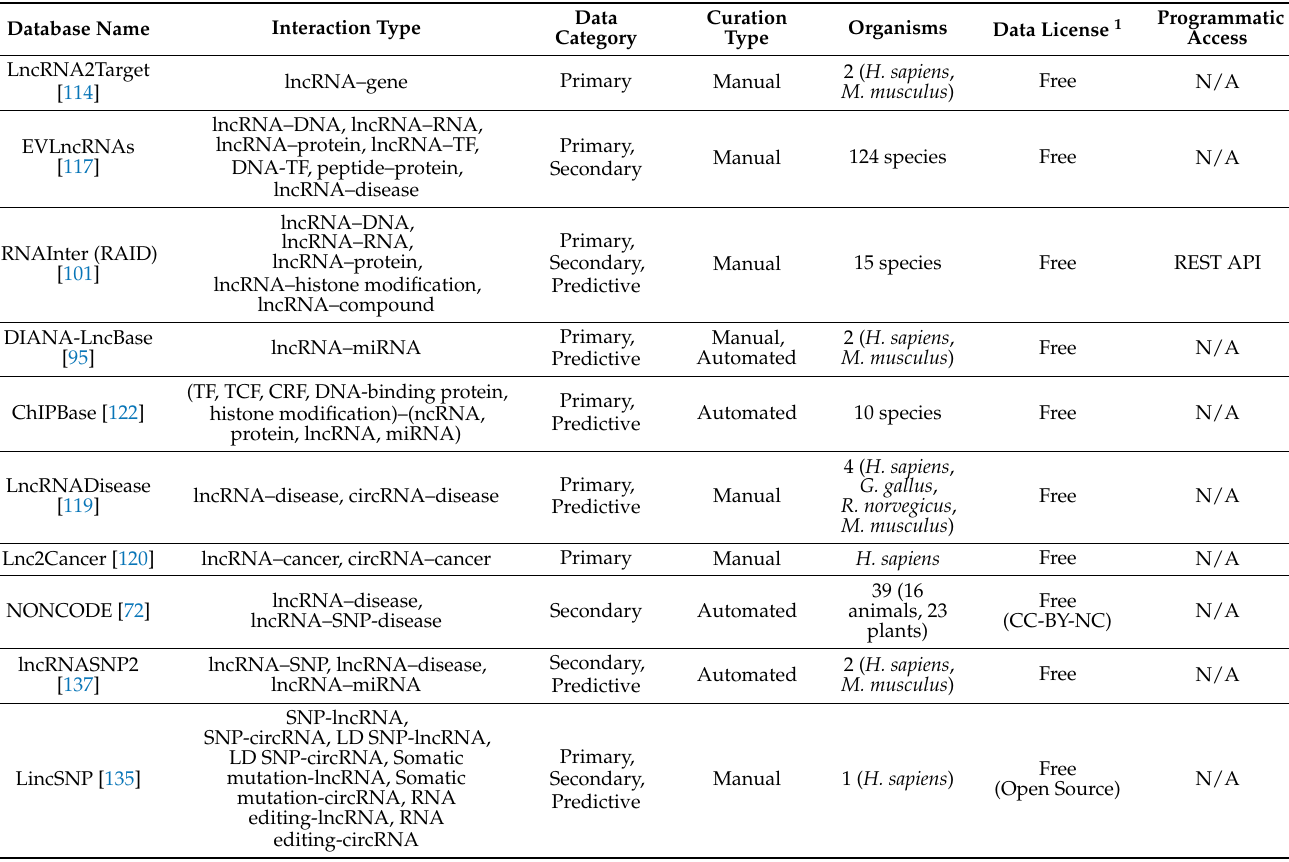
Table 4. LncRNA–target interaction